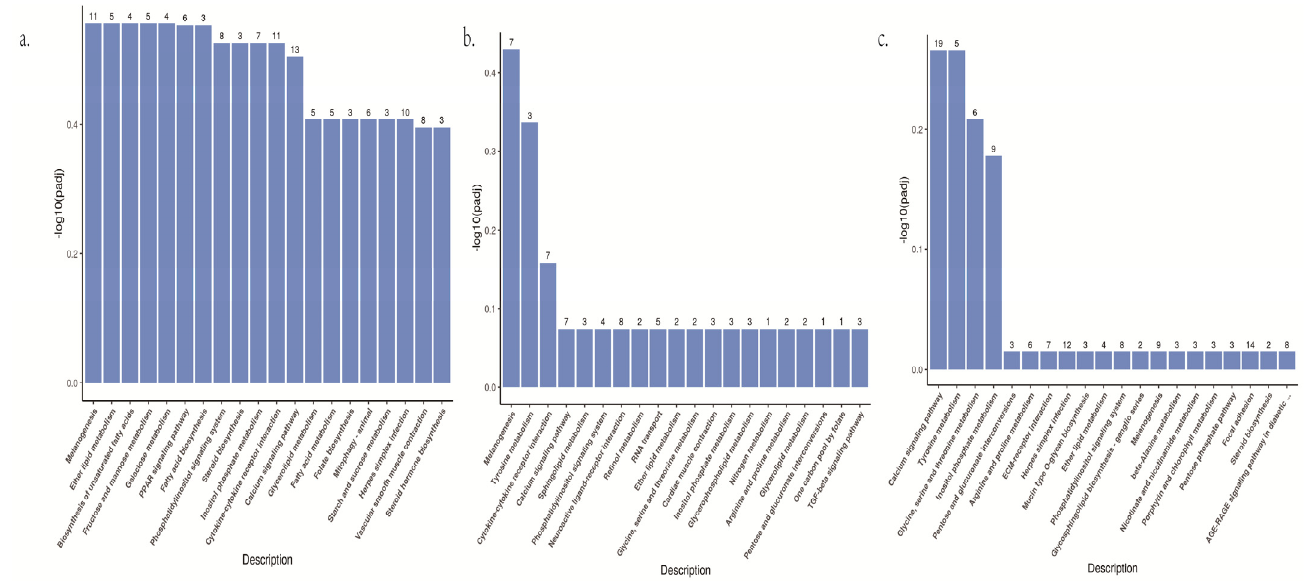
Figure 3. ( a ). The bar graph of KEGG pathway enrichment of DEGs in white vs. yellow. ( b ) The bar graph of KEGG pathway enrichment of DEGs in brown vs. yellow. ( c ) The bar graph of KEGG pathway enrichment of DEGs in white vs. brown.